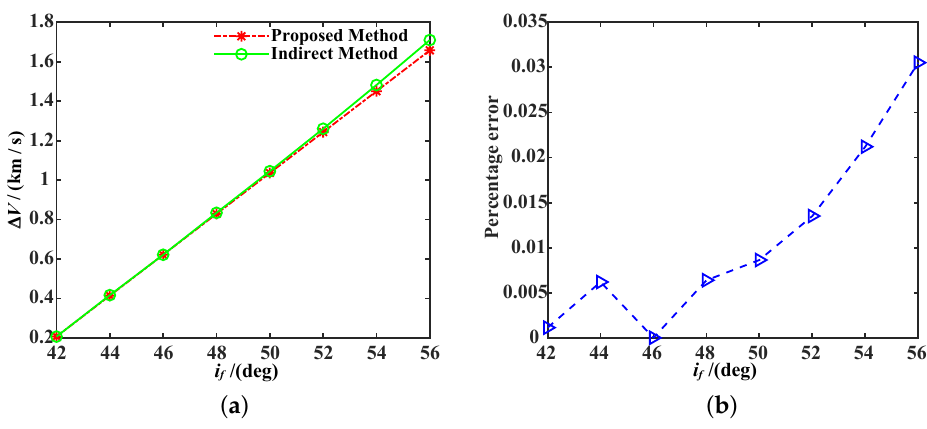
Figure 4. Comparison of ∆ V , for example 1. ( a ) ∆ V solved by the two methods. ( b ) Percentage error of the estimation of ∆ V